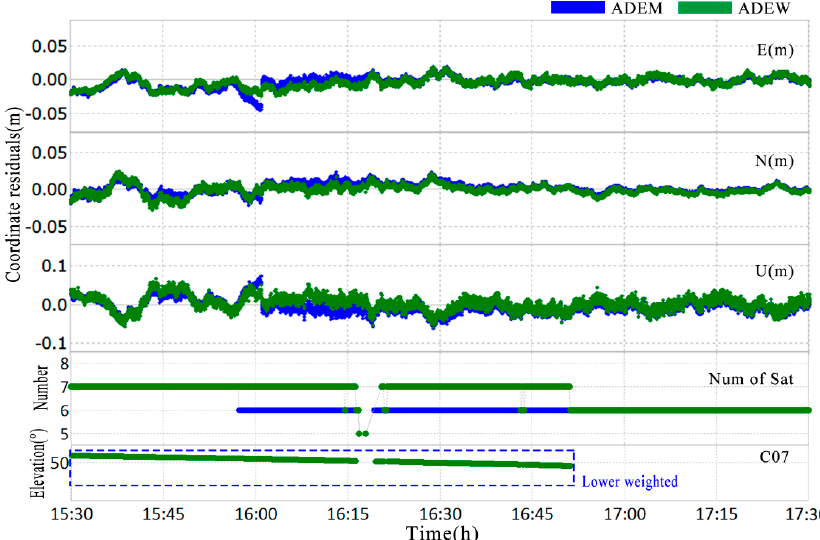
Figure 12. Deviation of the fixed coordinate time series using the ADEM method (blue) and the ADEW method (green) from 15:30 to 17:30 of NQ02 ( top ); the number of satellites used for the estimation ( middle ); the session dealing with C07 in the ADEW method ( bottom ).